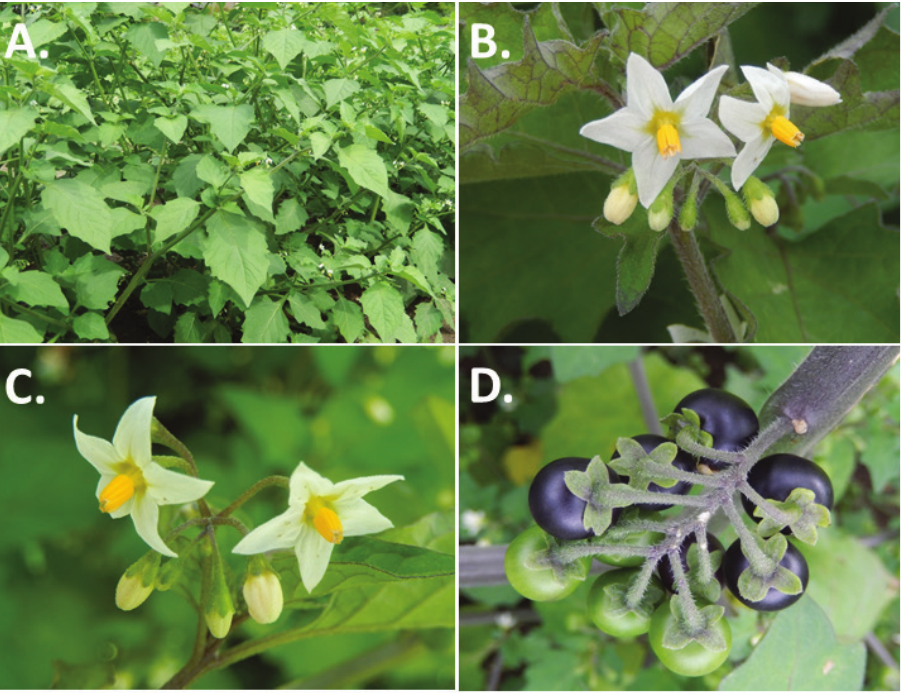
Figure 31. Solanum nigrum L. A Habit B inflorescence (dense indumentum) C inflorescence (sparse indumentum) D fully mature full-black berries, calyx lobes remaining appressed or slightly spreading ( A Nijmegen acc. 824750016 B Nijmegen acc. A34750479 C Nijmegen accession 824750029A D Ni- jmegen accession A44750150). Photos by S. Knapp (previously published in “PhytoKeys